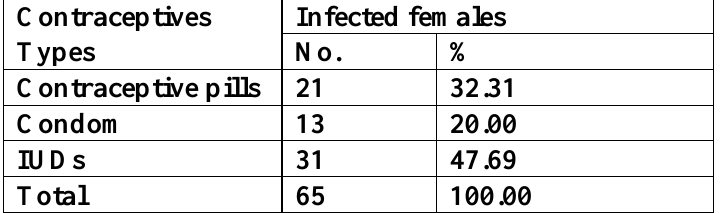
Table (8): Relation between different contraceptive methods and Trichomoniasis